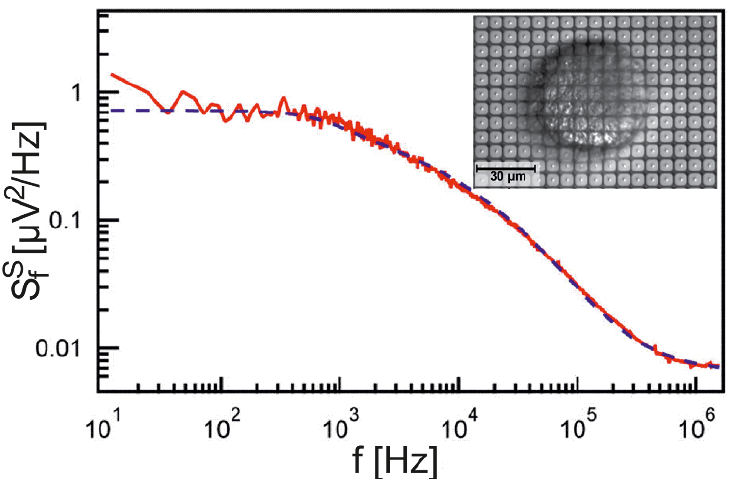
Figure 3. Power spectral density (PSD) of the fluctuating extracellular voltage V J in a cell–substrate junction (by permission [26]). The PSD of a dissociated neuron from Lymnaea stagnalis is probed with an array of EOMOS transistors (insert). The logarithm of the net PSD per frequency interval for the sensor transistor in the center of the adhesion area (after subtracting the PSD without cell) is plotted versus the logarithm of the frequency (red trace). The data are fitted by the PSD of the thermal voltage fluctuations in a planar capacitive core-coat conductor with a sheet resistance r J = 109 M Ω and a capacitance (whole cell) of c J = 0.74 µF/cm 2 (blue dashed trace).